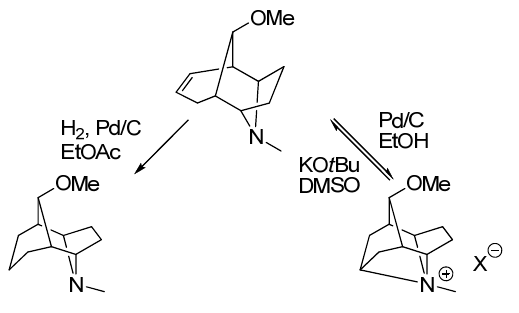
Figure 10. Recycling of the amine donor ( left ) and side reaction ( right ) [123].